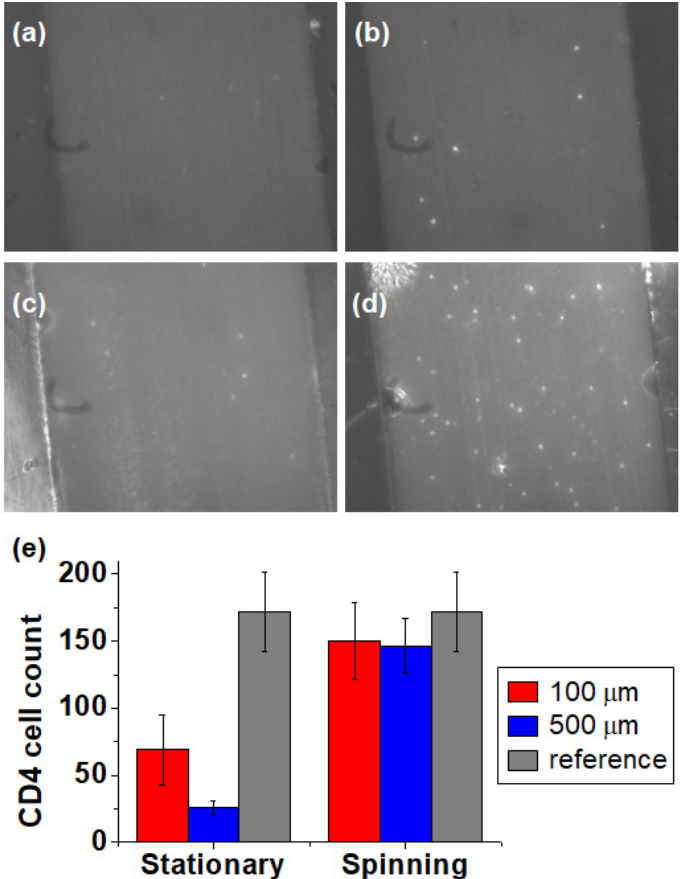
Figure 9. CD4 cell counts before and after spinning for different channel depths (100 and 500 μ m); ( a ) before and ( b ) after spinning in a 100- μ m-deep channel; ( c ) before and ( d ) after spinning in a 500- μ m-deep channel; ( e ) comparison of the number of CD4 cells per μ L before and after spinning in each channel with the reference value determined by manual counting using a C-Chip.